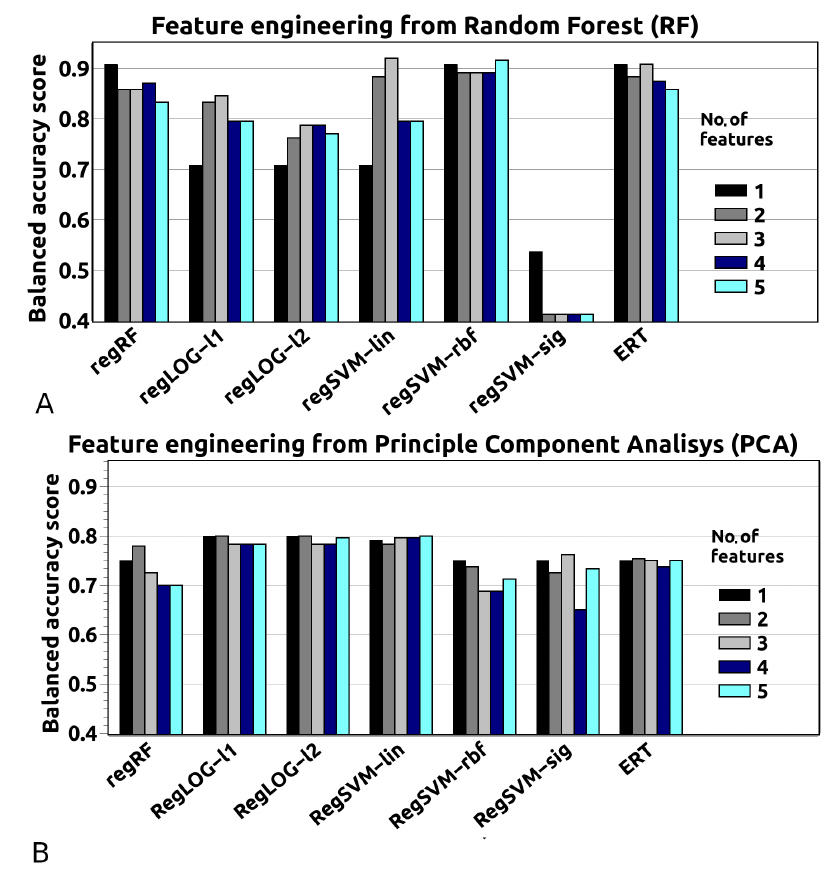
Figure 3. Feature engineering for dataset III obtained for two methods: ( A ) Random Forest (RF) and ( B ) Principle Component Analysis (PCA). Both methods are methodological tools that allow simplification of the